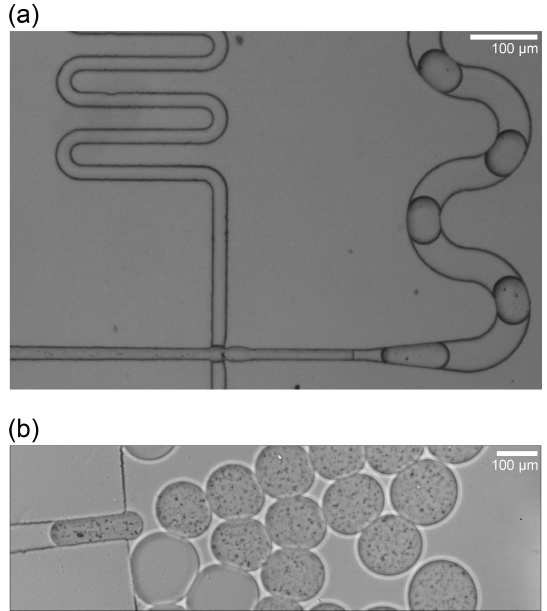
Figure A2. Microfluidic droplets of aqueous suspensions contain- ing (a) 0.1wt% and (b) 2wt% microcline that were neither soni- cated nor filtered. Microcline particles in these droplets are clearly visible as black pixels in both images. The slight difference in droplet sizes can be attributed to partial clogging of the droplet- generating orifice due to the high concentration of large mineral particles in this particular experimental